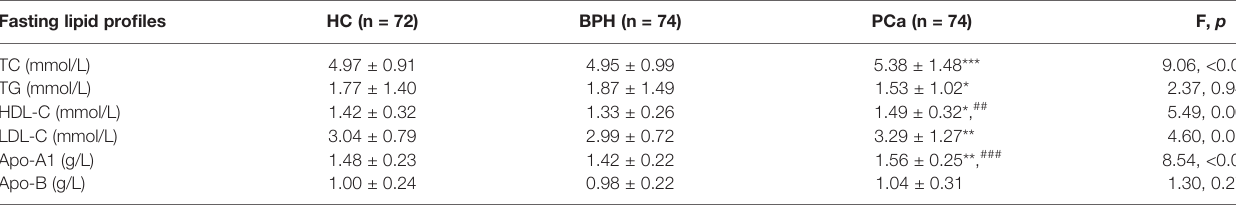
TABLE 4 | Serum lipids and apolipoproteins pro fi le for